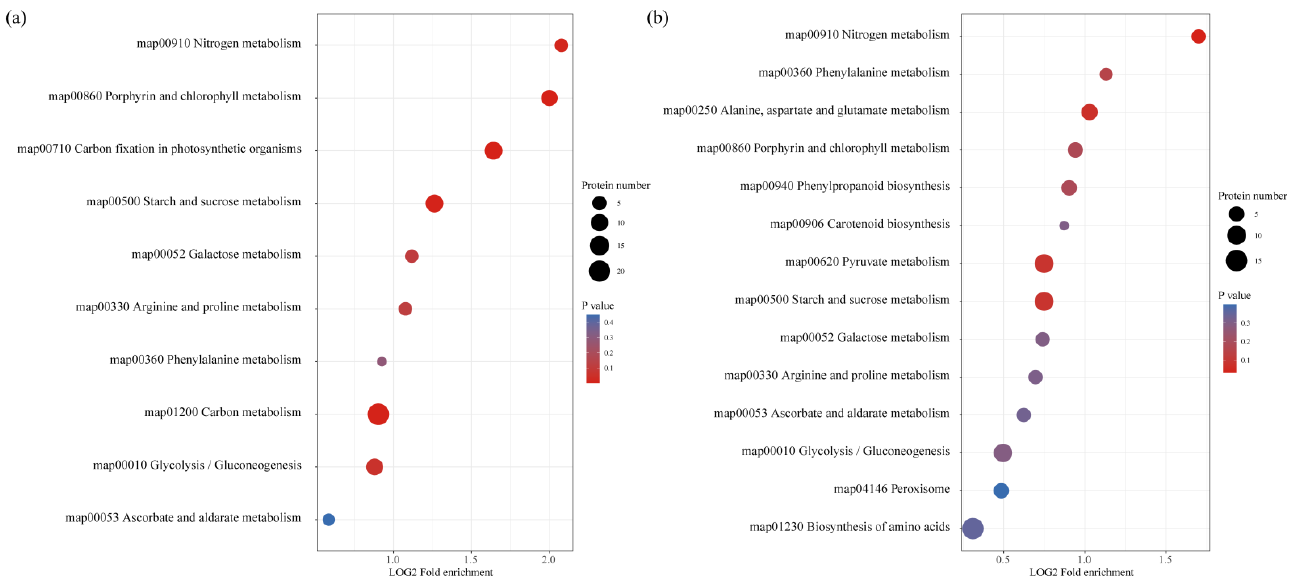
Figure 4. KEGG analysis of DAPs in pitaya stems under drought-stress conditions at 6 h ( a ) and 3 days ( b ).